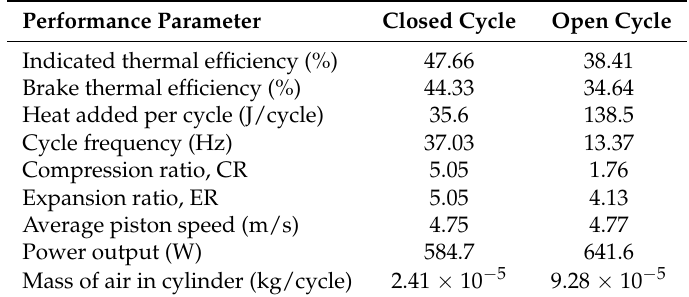
Table 1. Comparison of the performance metrics for the reference actuator in closed and open cycles with equivalence ratio φ = 0.51.